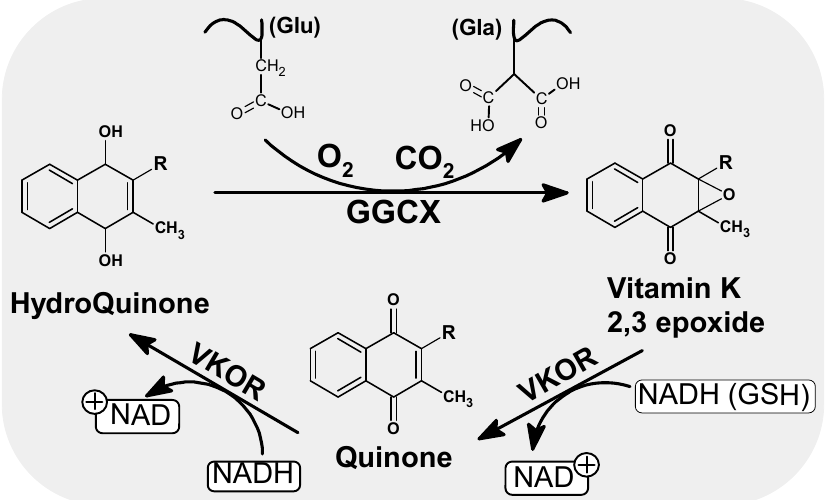
Figure 2. Scheme of the oxidation and reduction of quinones in the cell. As a result of GGCX catalyzed carboxylation in the presence of hydroquinone, CO 2 and O 2 , the Glu residues of the vitamin K dependent proteins are converted to gammacarboxyl glutamate (Gla). During this conversion, hydroquinone is oxidized to epoxide. Regeneration of the active form of vitamin K (hydroquinone) is handled by VKOR and leads to the consumption of other reduction equivalents such as NADH or/and GSH. NADH/NAD: Nicotinamide adenine dinucleotide (an oxidized and reduced form), GSH: Glutathione, VKOR: Vitamin K epoxide reductase.